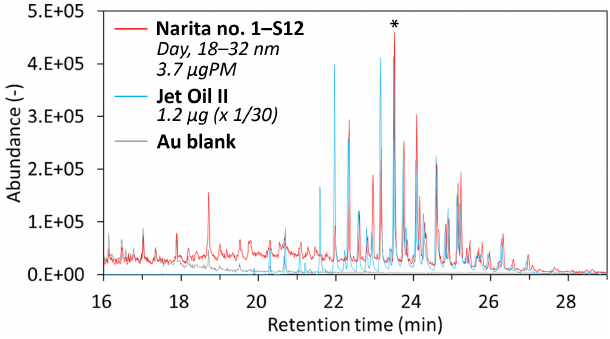
Figure 7. Mass chromatograms ( m/z 85) of a nanoparticle sample collected during the daytime (sample no. 1, 9–13 February 2018; S12, diameter: 18–32 nm) at the Narita International Airport, Jet Oil II, and Au-foil blank. The mass spectra of the peaks at 23.51min of Narita no. 1–S12 sample and Jet Oil II with an asterisk are shown in Fig.